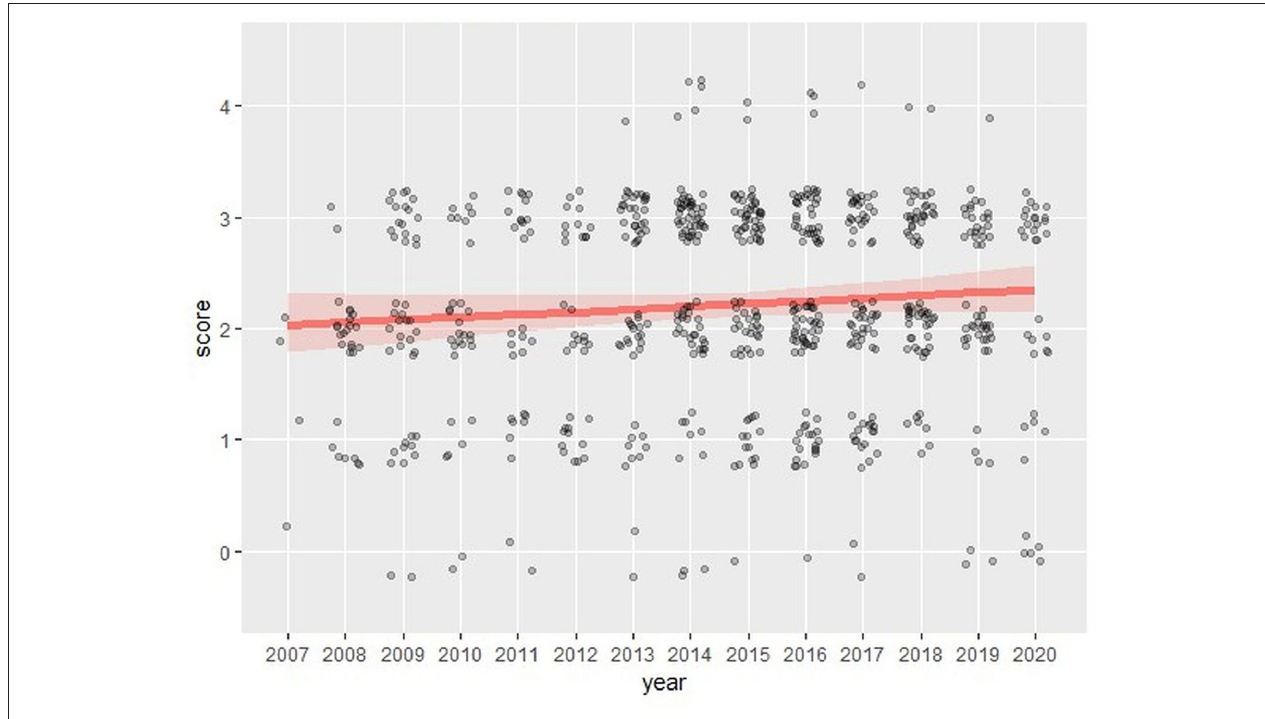
FIGURE 3 | Effect plot negative binomial regression for [pimp POSS N] excluding Pimp My